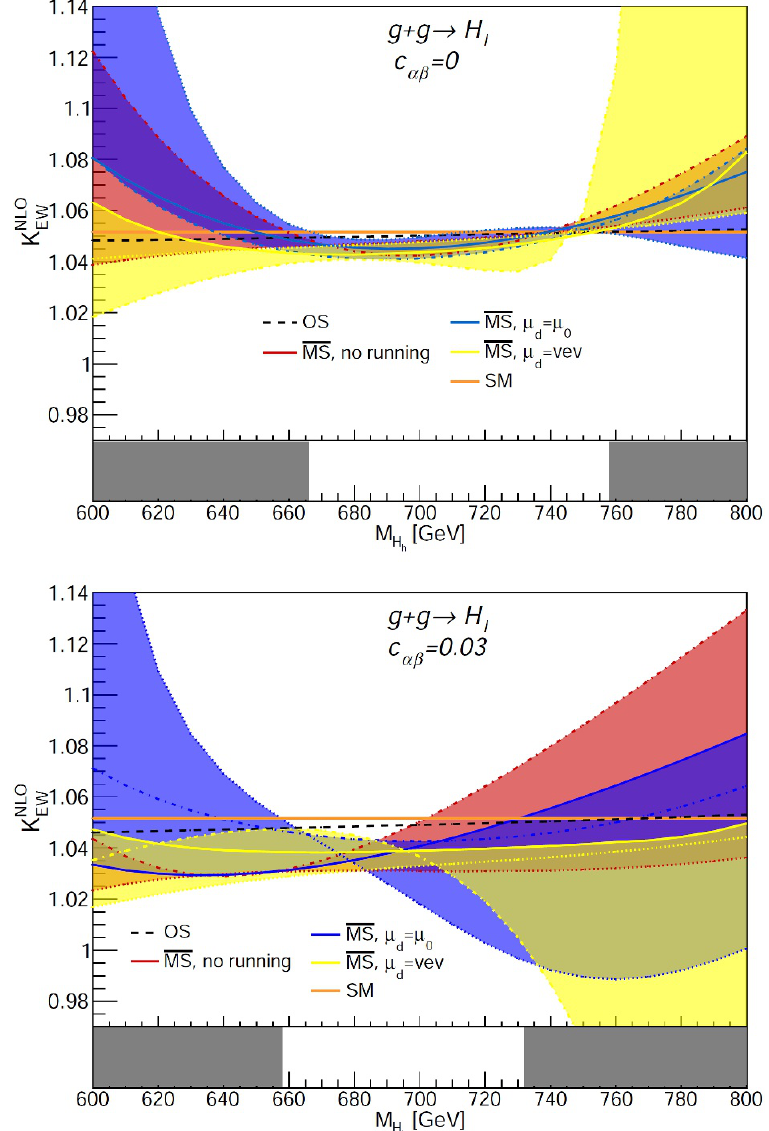
Figure 10 . The K-factors of the process g + g H l in various MS schemes are compared to the ! on-shell scheme and to the SM result. Solid lines are for (cid:22) = (cid:22) 0 , while dotted and dash-dotted lines refer to (cid:22) = (cid:22) 0 = 2 and (cid:22) = 2 (cid:22) 0 , respectively. The grey shaded band denotes the region where at least one of the couplings (cid:21) i = (4 (cid:25) ) ( i = 1 ; : : : 5) of the potential in eq. (2.2) becomes larger j j than 0.5 for at least one of the scales (cid:22) considered. The curve with (cid:22) = (cid:22) 0 for the case of the MS scheme without running coincides with the (cid:22) = (cid:22) 0 curve for the MS scheme with running, where the parameters are de(cid:12)ned at (cid:22) d = (cid:22) 0 , since in both cases the parameters have been de(cid:12)ned at (cid:22) 0 .